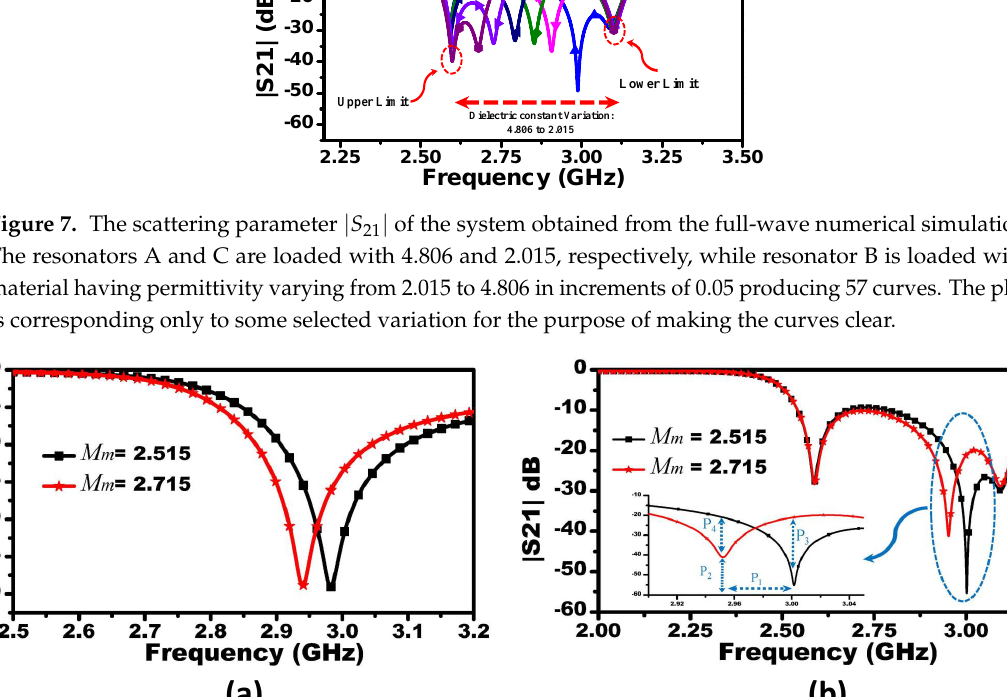
Figure 8. ( a , b ) The scattering parameter | S 21 | of the single CSRR and three CSRR based sensors, respectively, for M m having relative permittivity of 2.515 and